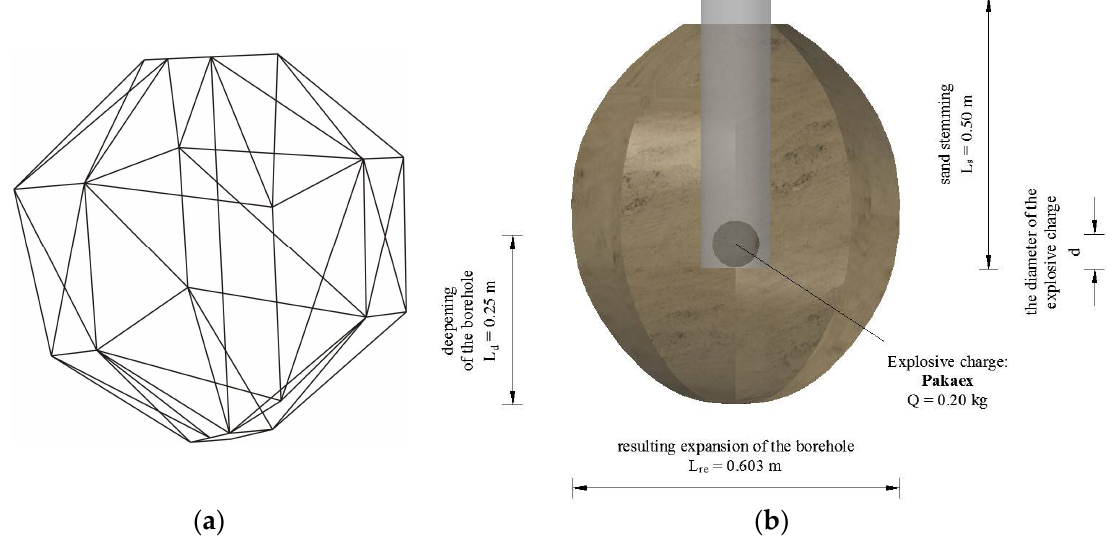
Figure 9. Borehole MB37 ( a ) Linear 3D model of the resulting expansion, application Borehole; ( b ) 3D model of the resulting expansion, AutoCAD Civil 3D [4].